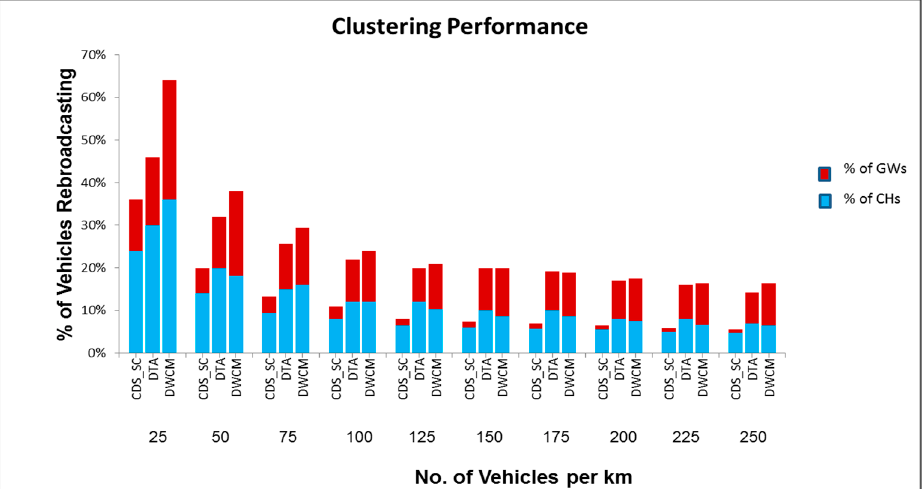
Figure 13. Clustering performance.